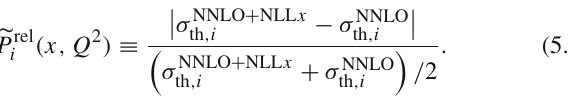
Fig. 25 Left panel: interpolated representation of the relative pull Eq. (5.5) between the HERA NC reduced cross-section data at and the NNLO fit, in the small- x and small- Q 2 region. Right panel: same as the left panel now for the NNLO+NLL x